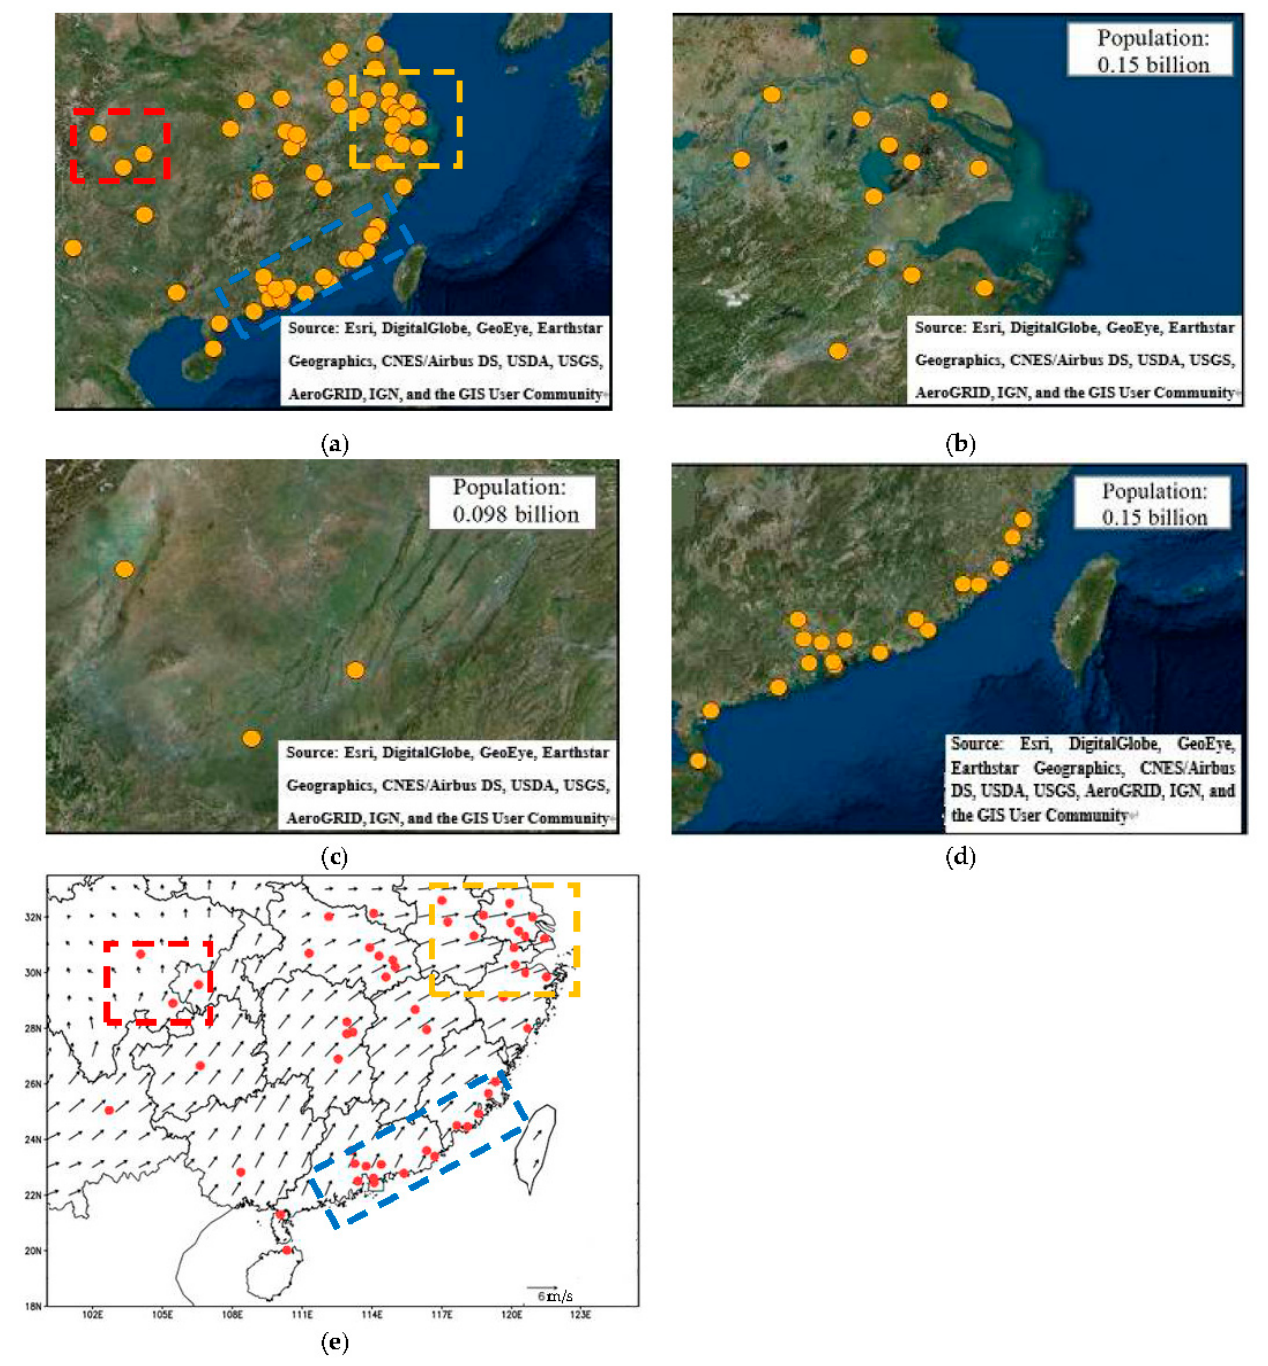
Figure 1. Distribution of cities with population over one million in 2016: ( a ) South China, ( b ) the Chengyu, ( c ) the Yangtze River Delta, and ( d ) Fujian Guangdong coast urban cluster. ( e ) Mean 700 hPa horizontal wind (m·s − 1 , May–September) based on ECMWF reanalysis dataset from 1998 to 2014. The solid dots indicate the cities with population over one million in 2016.